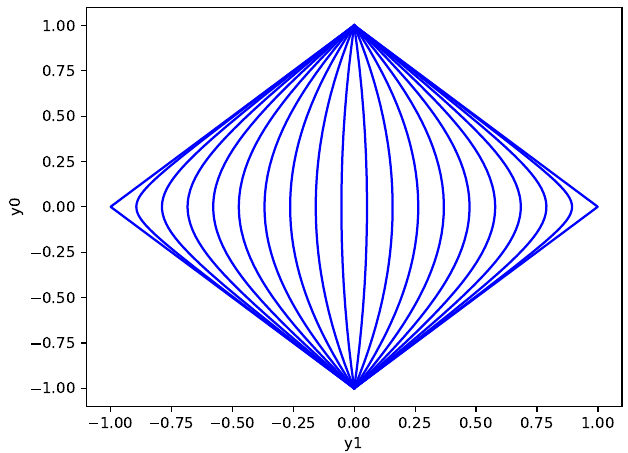
Figure 8 . An illustration for the trajectories of one interval modular flow. Where y 0 represents the time direction and y represents the space direction. As one can verify, these trajectories are 1 just the conformal isometries of the corresponding